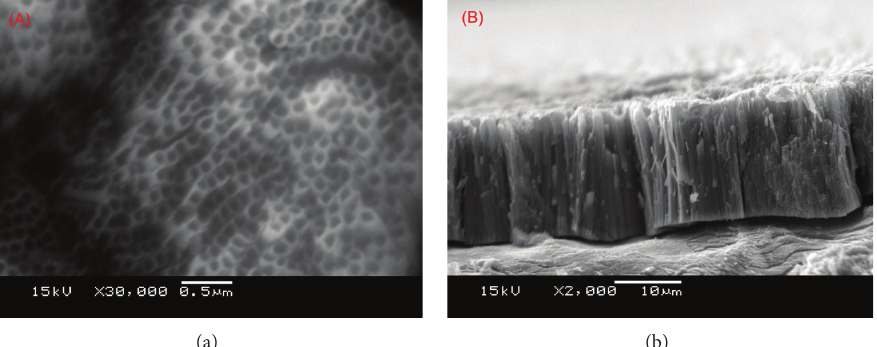
Figure 8: Morphologies of the TiO 2 nanotube arrays grown on electrochemical polishing-chemical etching Ti plates (a) top view and (b) side